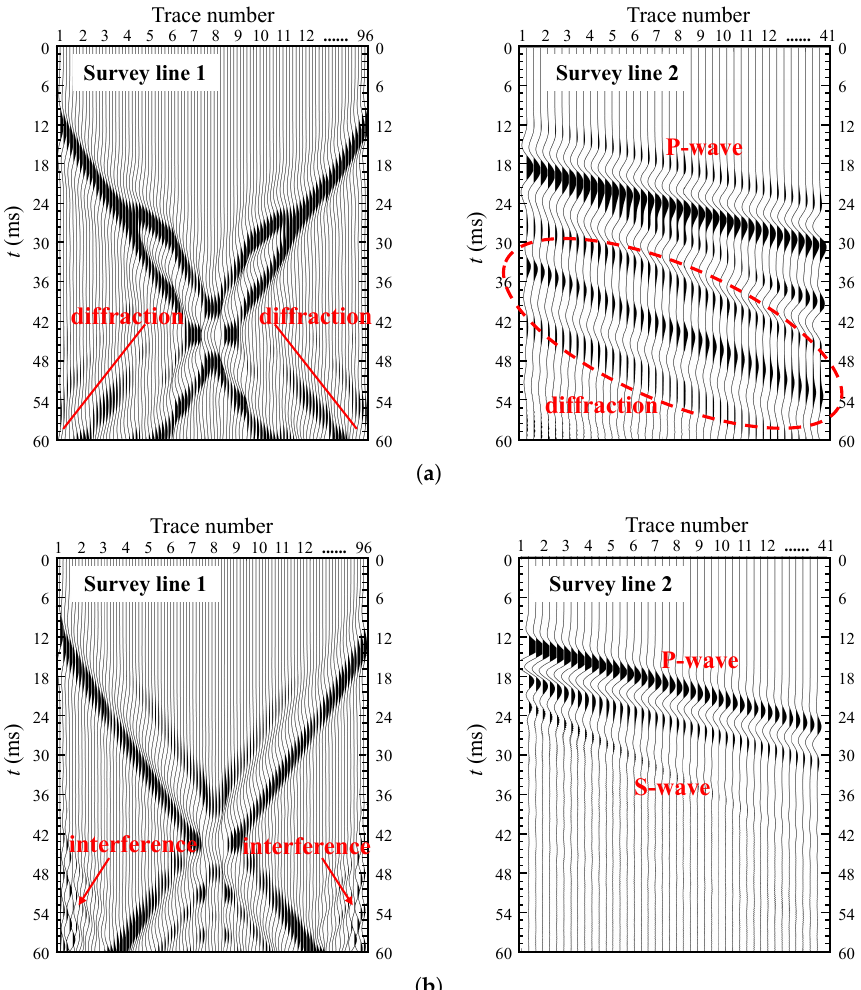
Figure 11. Seismic profiles in different coordinate systems. The seismic profile in ( a ) the cylindrical coordinate system and ( b ) the Cartesian coordinate